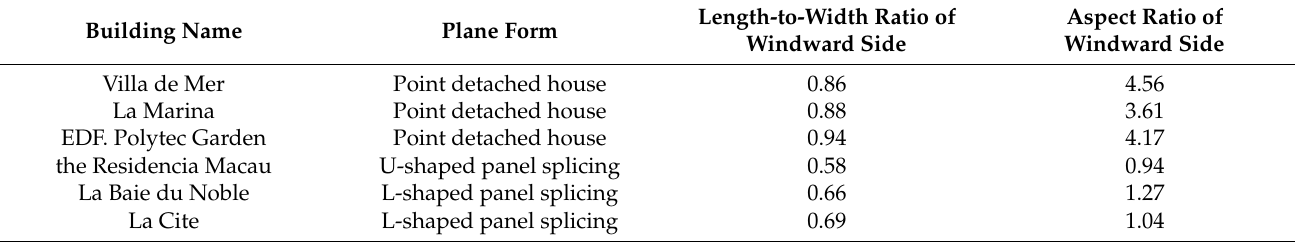
Table A3. Survey Form for Windward Scale of High-Rise Residential Buildings in Areia Preta.